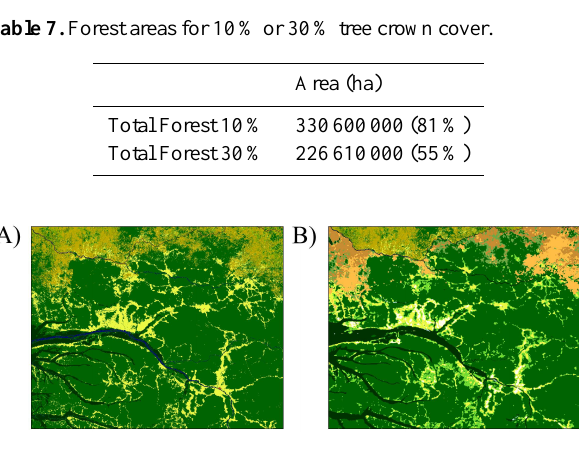
Fig. 10. Rural complex patches in forest of DRC (A) Congo Basin Vegetation types map, (B) Vegetation types map of DRC (Vancut- sem et al., 2009).